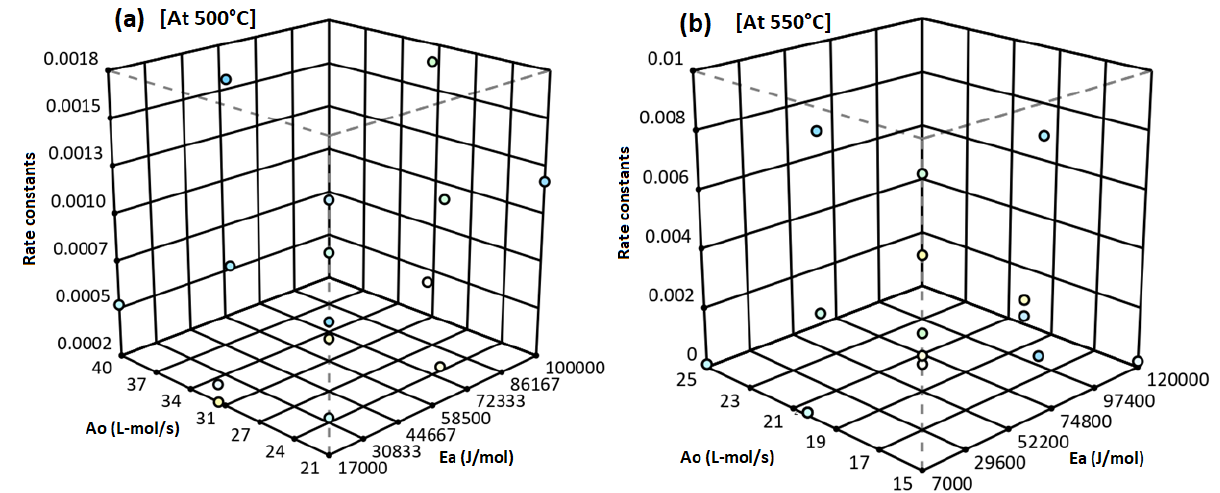
Figure 2. Verification of runs for maximum and minimum values of dependent and independent factors at ( a ) 500 °C and ( b ) 550 °C. Table 2. The factors and responses for the predicted model. Table 3. ANOVA for the suggested and analyzed model at different